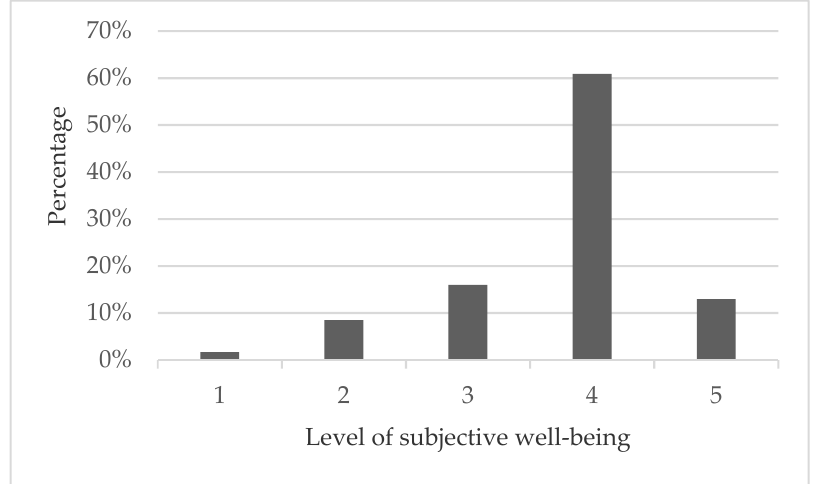
Figure 3. Subjective well-being of rural residents.